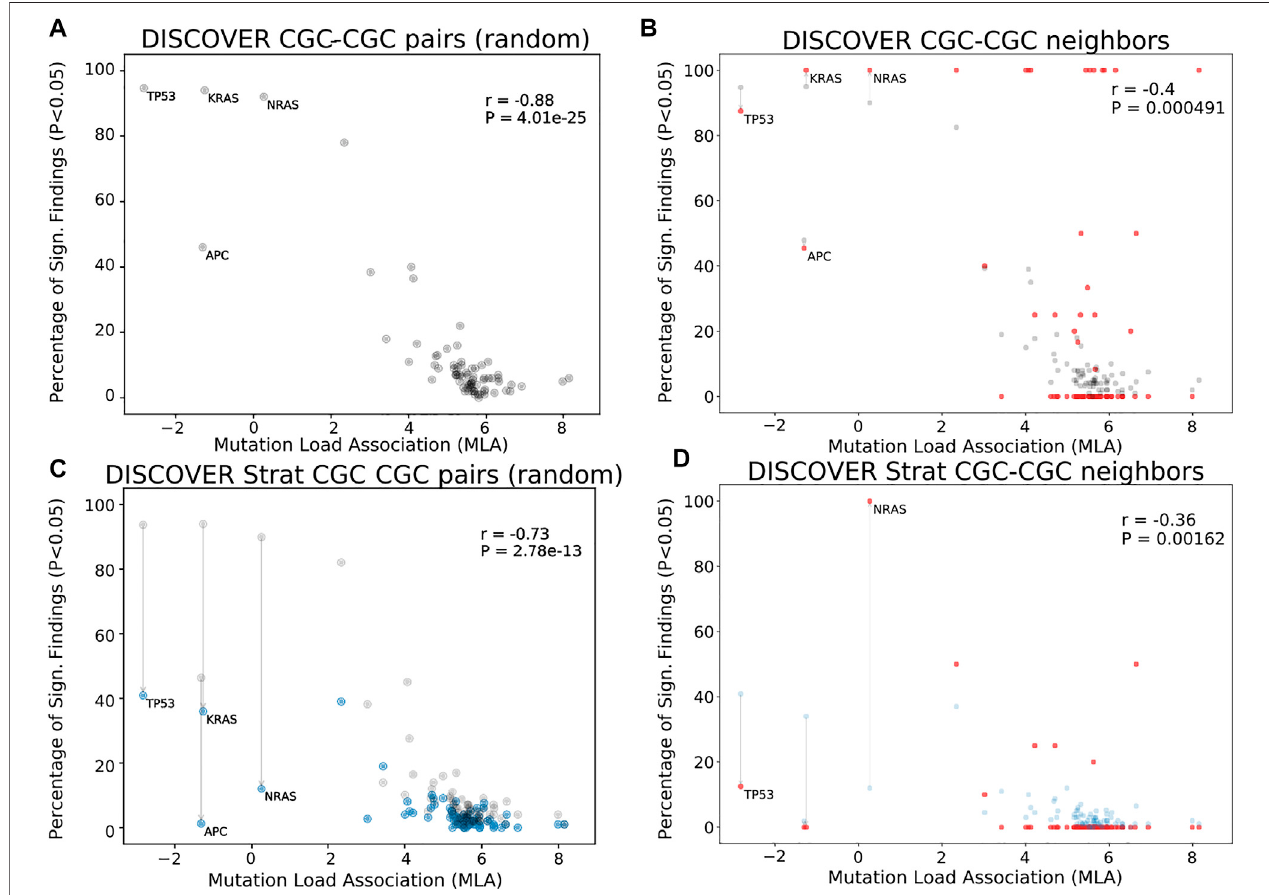
FIGURE 1 | Comparison of mutual exclusivity results of DISCOVER and DISCOVER Strat on TCGA COADREAD cohort (498 samples) (A) The scatterplot of percentage signi fi cance of ME runs ( p -value < 0.05) of DISCOVER on COADREAD data where tests are performed between a CGC gene and a random subset of other CGCgenessothatMEofaCGCgeneofinterestischeckedwithsamesizedgroupofgenesinbothAandB. (B) Thescatterplotofpercentagesigni fi canceofMErunsof DISCOVER where tests are performed between a CGC gene and its PPI neighbors that are in CGC (red) compared with (A) in gray. (C) The scatterplot of percentage signi fi cance of mutual exclusivity runs ofDISCOVER Strat where tests are performed between a CGC gene and a random subset of other CGC genes(blue) sothatMEofaCGCgeneofinterestischeckedwithsamesizedgroupofgenesinbothCandD,resultsfrom (A) areshowningrayforcomparison. (D) Thescatterplotof percentage signi fi cance of mutual exclusivity runs of DISCOVER Strat where tests are performed between a CGC gene and its PPI neighbors that are in CGC (red) compared with (C) in blue.